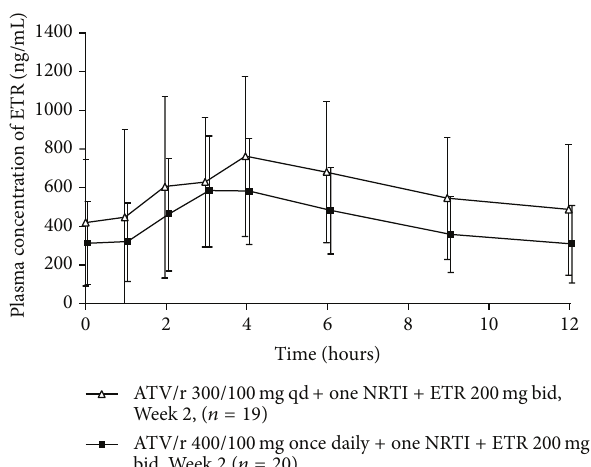
Figure 4: Mean ± standard deviation etravirine plasma concentra- tion-time curves after administration of etravirine 200 mg bid for two weeks in combination with atazanavir/ritonavir 300/100 mg qd or 400/100 mg qd and one NRTI. ATV/r: atazanavir/ritonavir; bid: twice daily; ETR: etravirine; NRTI: nucleoside reverse transcriptase inhibitor; qd: once daily.